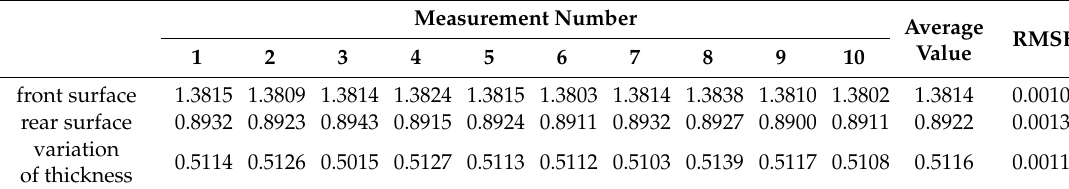
Table 2. The result of the peak-to-valley (PV) value of three surfaces obtained by 10 repeated measurements using the 36-step algorithm ( µ